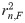
Decoding the single trial stimulus class and onset time from a continuous data stream using ERP: Illustration of three electrodes and the continuous classifier using 3 ERP-templates-to-voltage-timeseries projections (subject 4).
(A) Three cortical sites are shown for illustration (purple, orange, and green). The axes on the right show the rn,F2 (blue asterisk, r2 of faces-vs-ISI) and rn,H2 (pink box, r2 of houses-vs-ISI) of ERP-voltage training projections show that these purple/orange/green sites are highly selective for faces or houses during the training period (from the 1st cross-fold). Features falling below the black line were not used for decoding. (B) Averaged face and house ERPs, 〈V
n(t')〉F & 〈V
n(t')〉H, from each site are shown on the left axes. These are projected into the raw voltage traces from the testing period (V
n(t), black) to obtain continuous projection weight traces (Γn,F/HV; green–face projection from green electrode, orange–house projection from orange electrode, and purple–face projection purple electrode). These traces are fed into a feature space and classified continuously to obtain posterior probability of a face, Pr{Γ(t)|q → F} (blue), or house stimulus, Pr{Γ(t)|q → H} (pink) (bottom plot). (C) A 3-dimensional subspace (from the sites in A and B) is illustrated, with training points from the training period shown with dots, and the subspace trajectory of the brain state, Γ(t), shown with a black line. Predicted and actual timing and type of stimulus are shown along this trajectory.